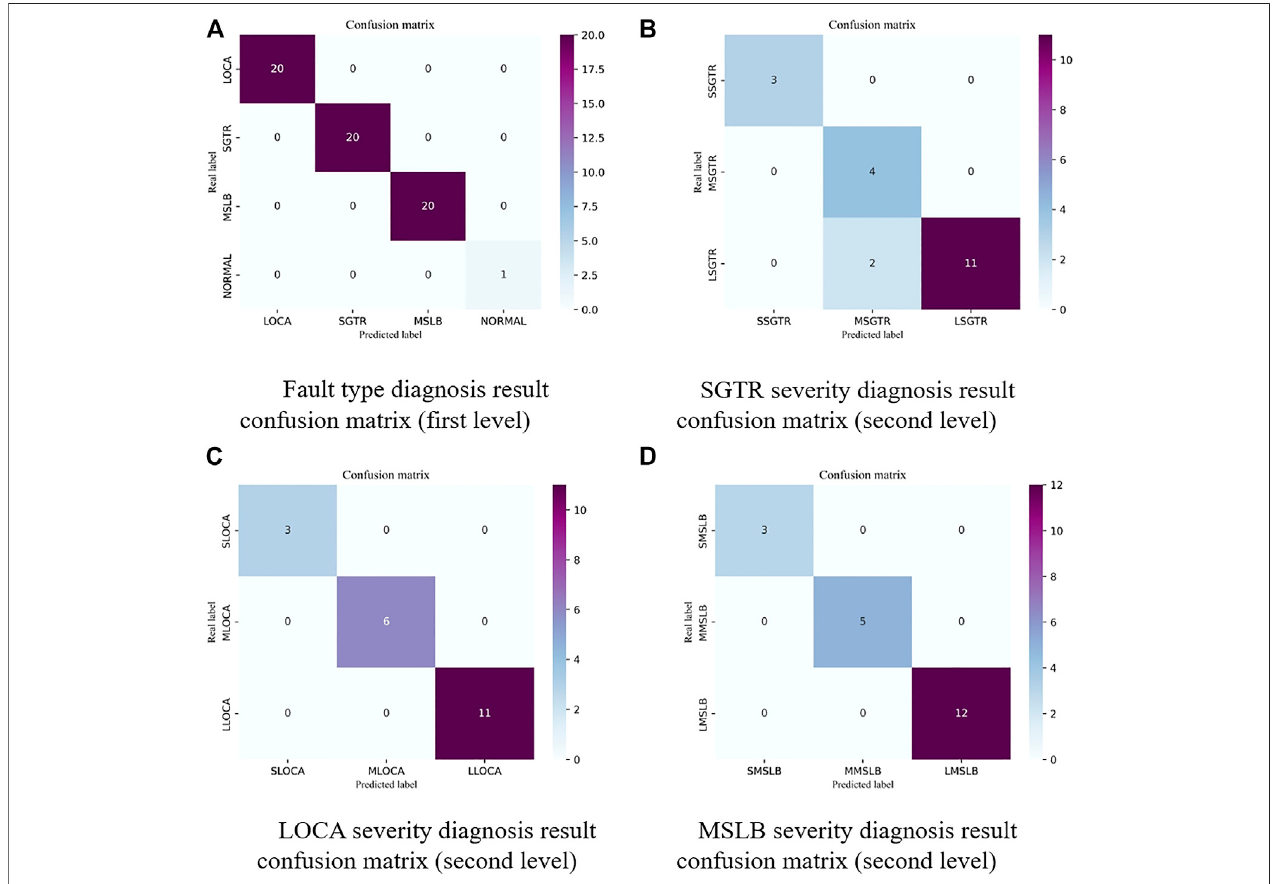
FIGURE8| ConfusionmatrixofdiagnosticresultsofSBN-ANNmodelat10 smoment. (A) Faulttypediagnosisresultconfusionmatrix( fi rstlevel) (B) SGTRseverity diagnosis result confusion matrix (second level) (C) LOCA severity diagnosis result confusion matrix (second level) (D) MSLB severity diagnosis result confusion matrix (second level).